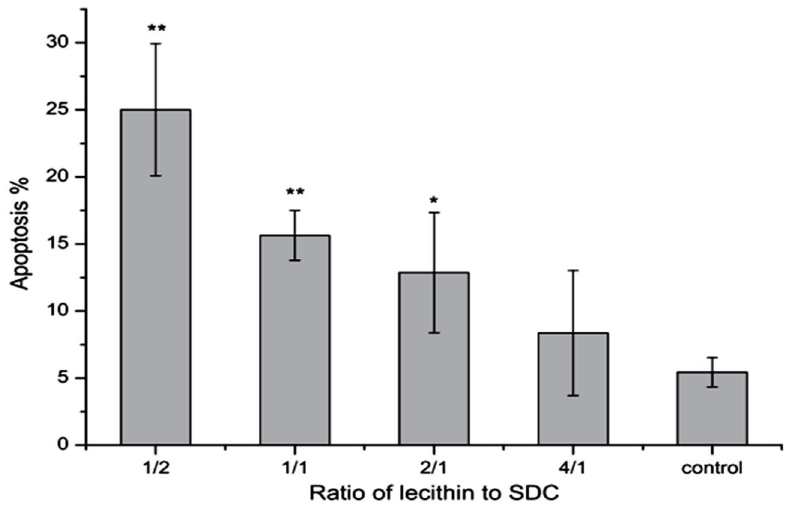
Figure 8. Effects of 0.2 mM mixed micelles with different lecithin/NaDC ratios on the apoptosis of Caco-2 cells ( n = 5) [108]. * p < 0.05, ** p <